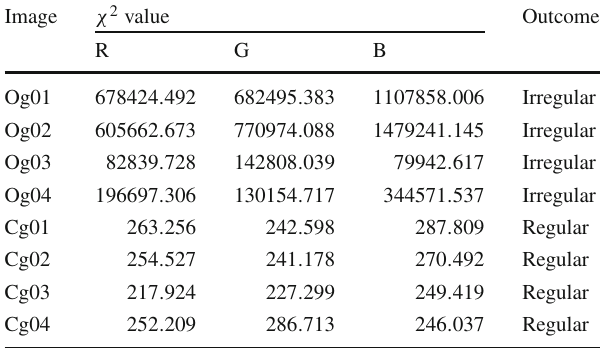
Table 5 Results of UACI and NPCR tests